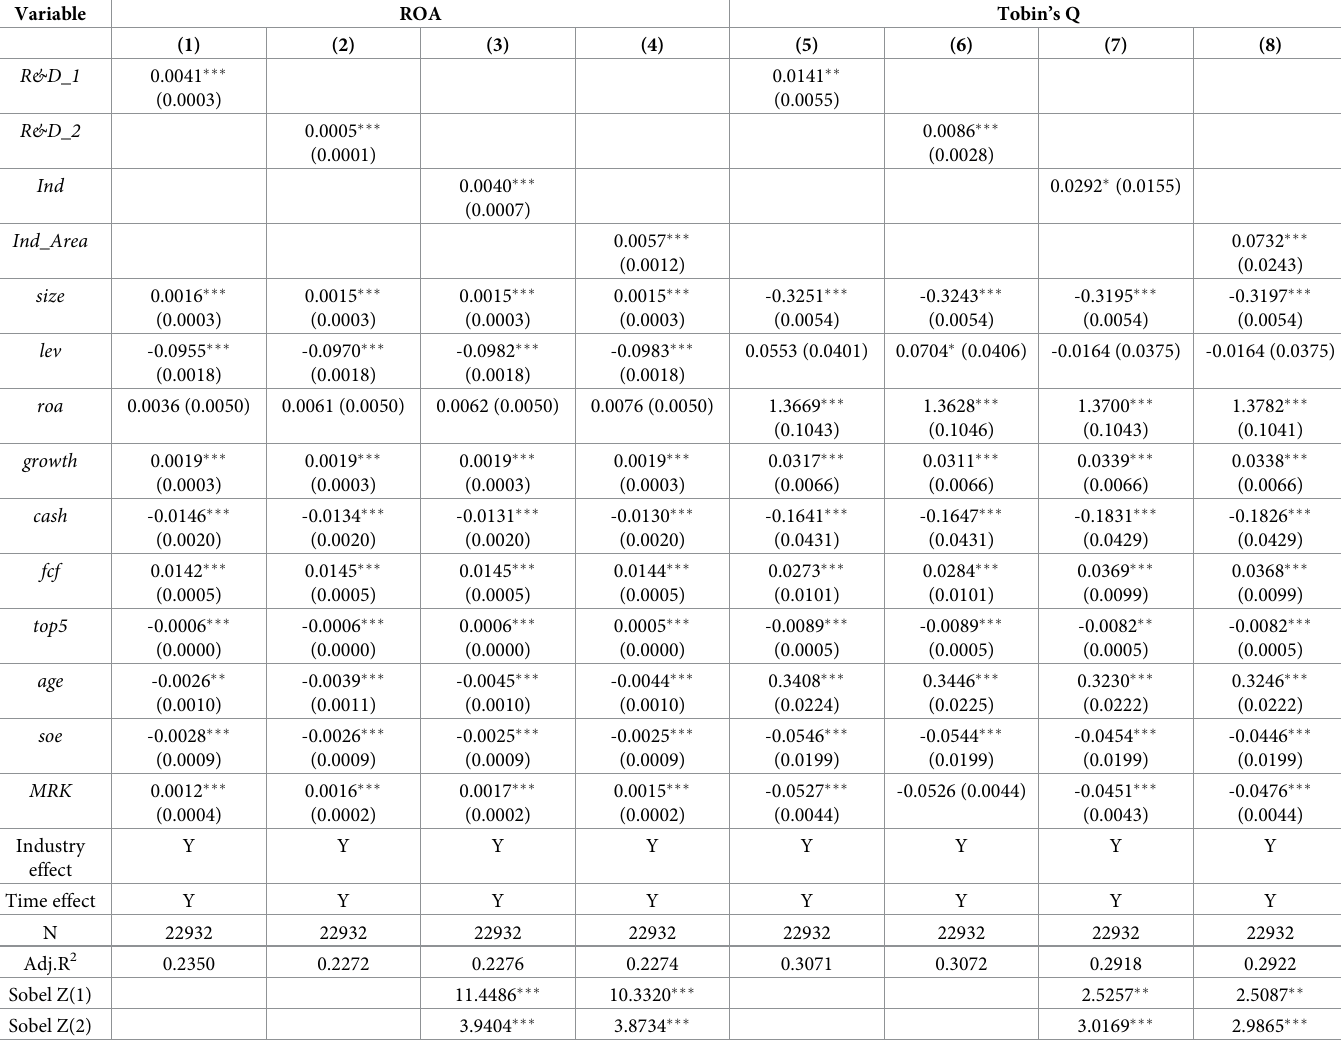
Table 9. Do the ripple effects of CEO awards increase firm